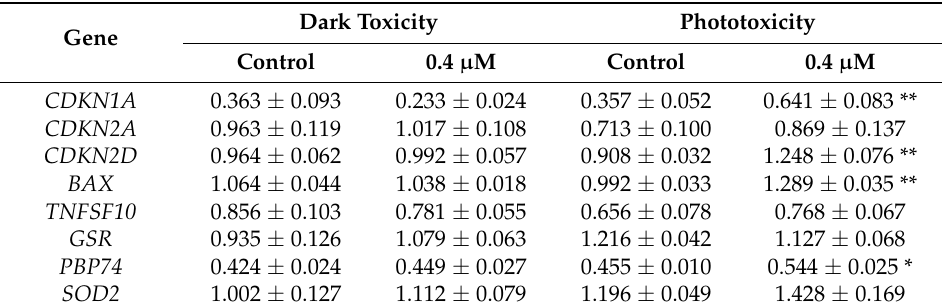
Table 3. Relative expression of genes of stress-response systems in HeLa cells after treatment with Compound 21 (0.4 µ M) in the dark and with